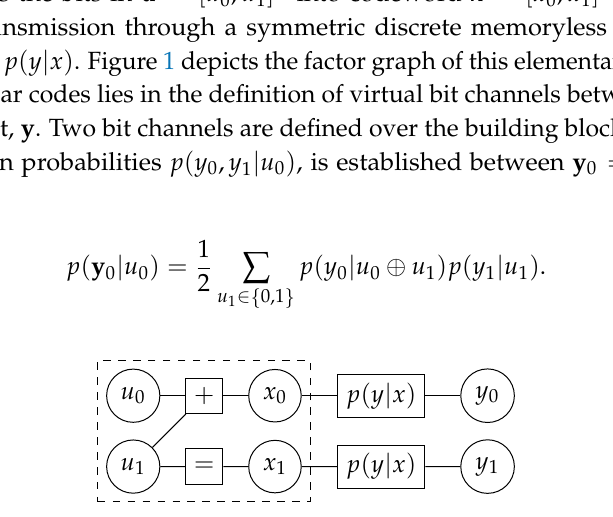
Figure 1. Factor graph of the building block (dashed rectangle) of a polar code along with the transmission